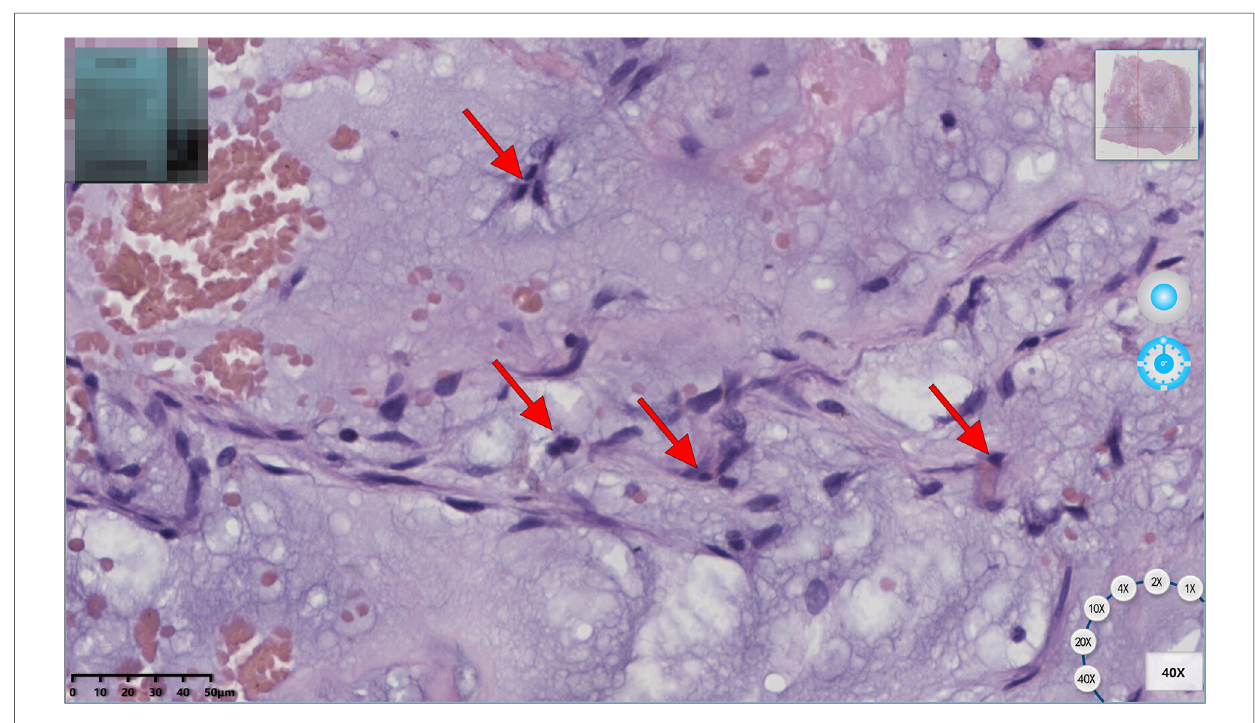
FIGURE 3 Histology found that myxomatous cells were irregular in shape and sparsely dispersed in the interstitial spaces (red